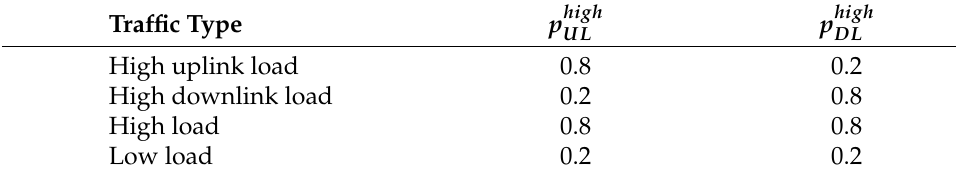
Table 4. Traffic